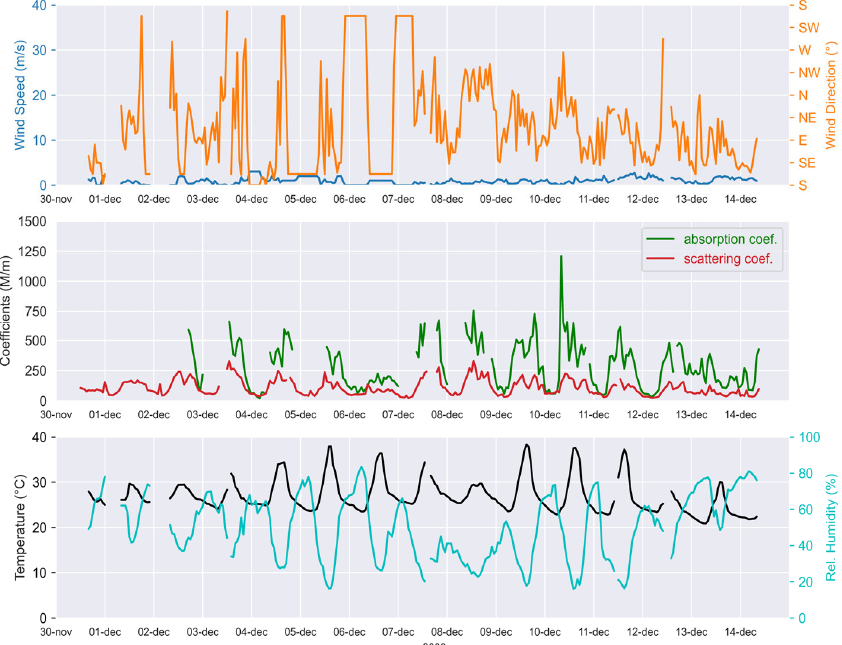
Figure 3. Light sca tt ering and absorption coe ffi cients, as well as meteorological data collected in Figure 3. Light scattering and absorption coefficients, as well as meteorological data collected in Dakar during the dry season of 2009 (30 November to 14 December). Dakar during the dry season of 2009 (30 November to 14